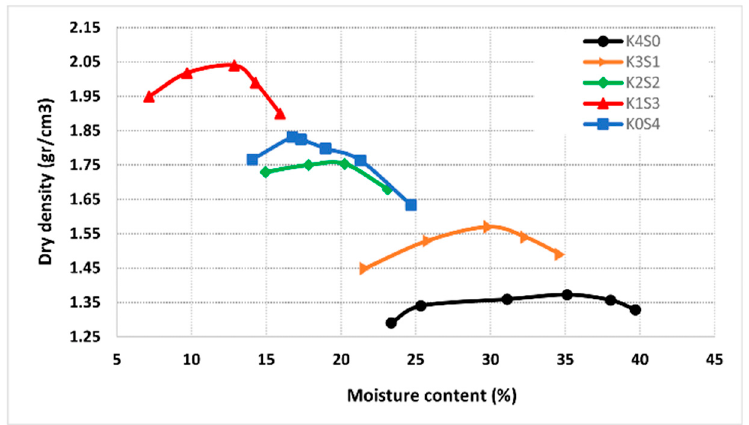
Figure A1. Compaction curves for sand-kaolinite mixtures.